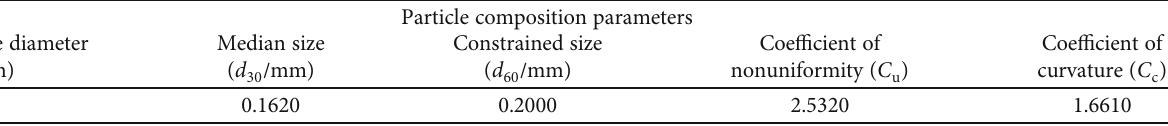
Table 1: Particle composition parameters of